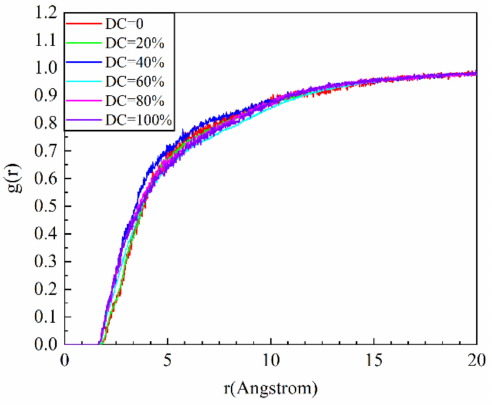
Figure 16. Intermolecular radial distribution functions of SEUG with different degrees of